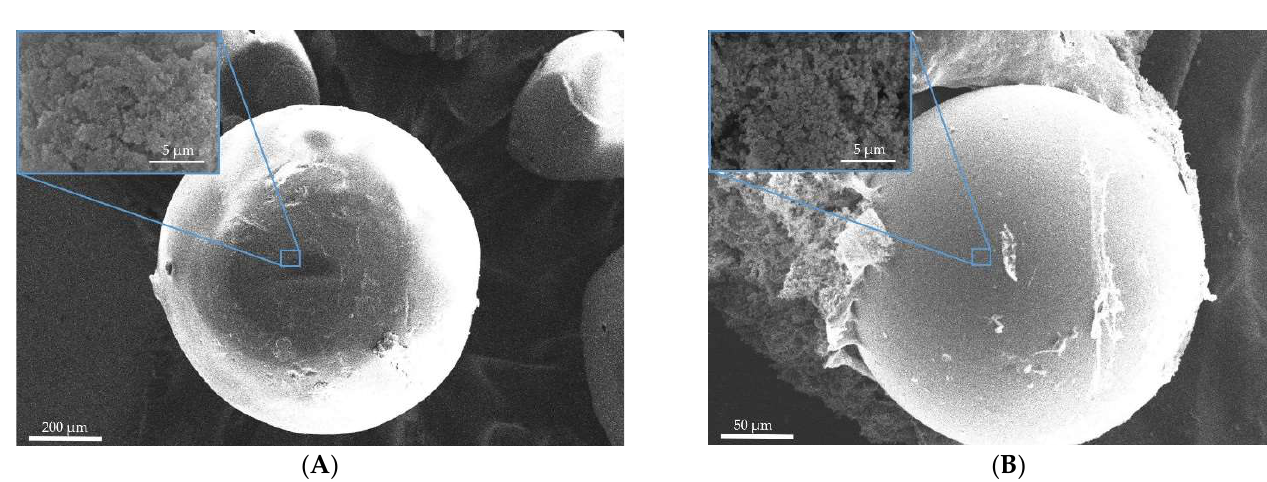
Figure 1. SEM images of the surface of the particles of aerogels based on egg white: ( A )—sample 1; ( B )—sample 2; ( C )—sample 3.